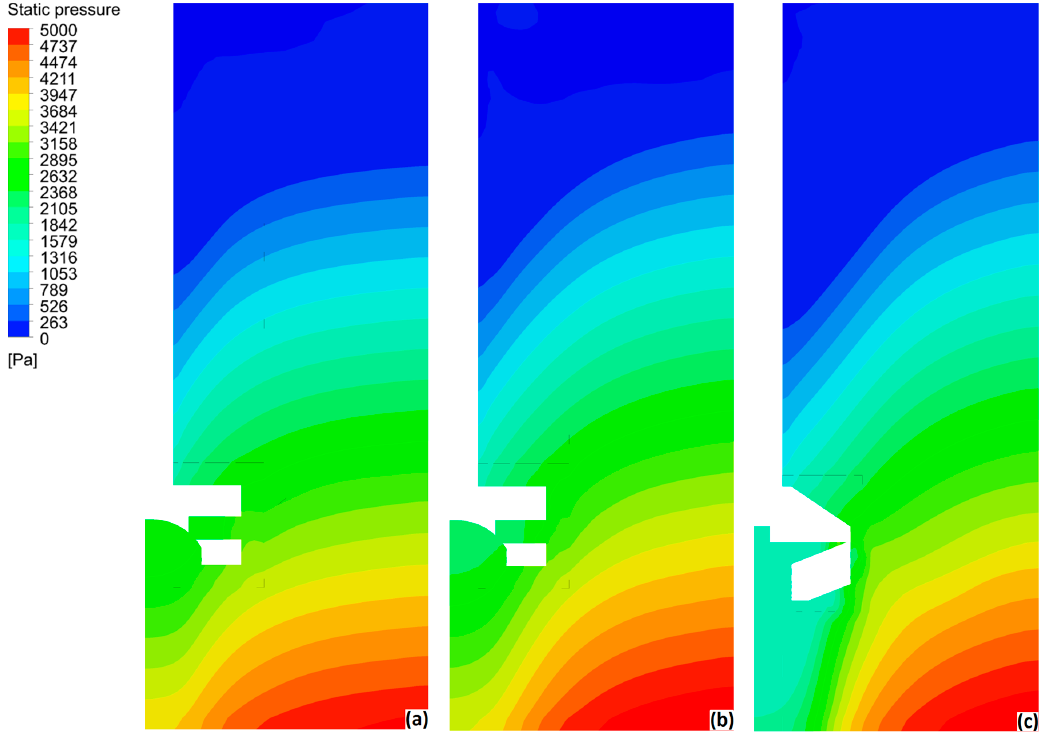
Figure 8. Pressure fields in the r-z plane of the ladle for the three impellers tested at 400 rpm and 10 L/min. ( a ) Impeller A; ( b ) impeller B; ( c ) impeller C.